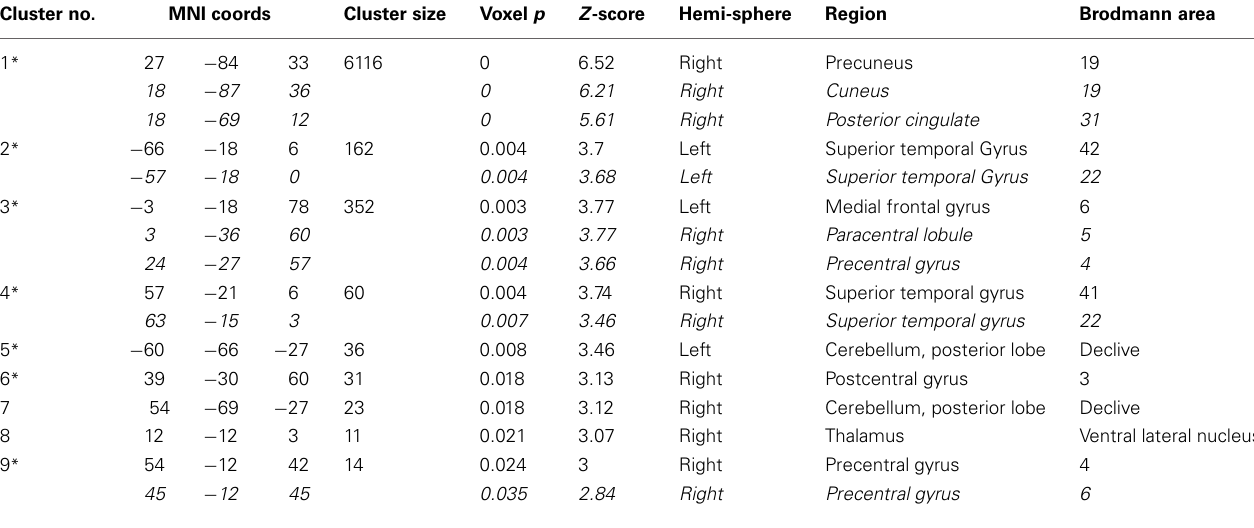
Table 3A | Areas where HC > SZ from the original ALFF analysis, in descending order of effect size. Cluster no. MNI